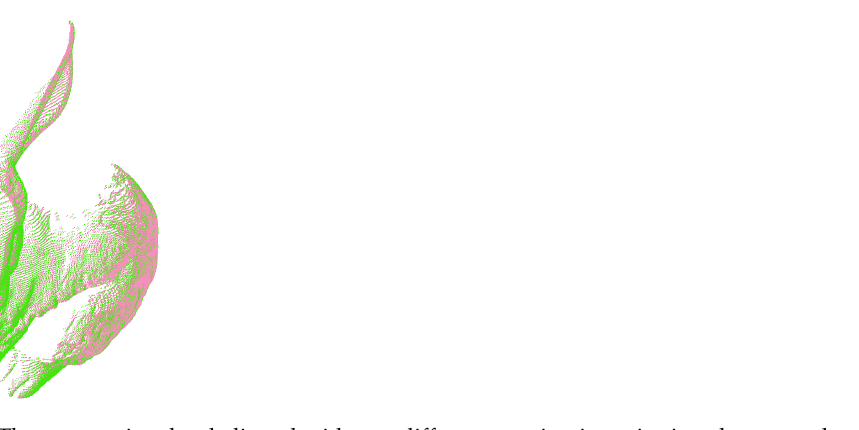
Figure 3. The same point cloud aligned with two different termination criteria: a large number of iterations (green point cloud) and our termination criterion based on the cost drop (pink point